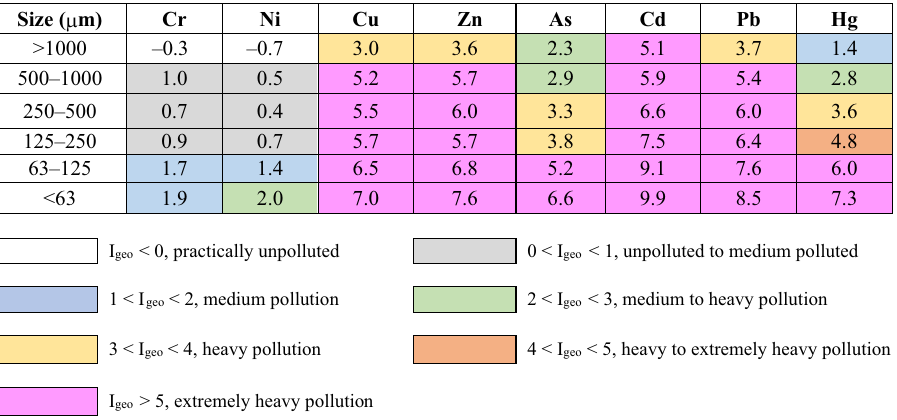
Table 3. Mean values of geo-accumulation index (I geo ) of PTEs in the different size of road deposited sediments.